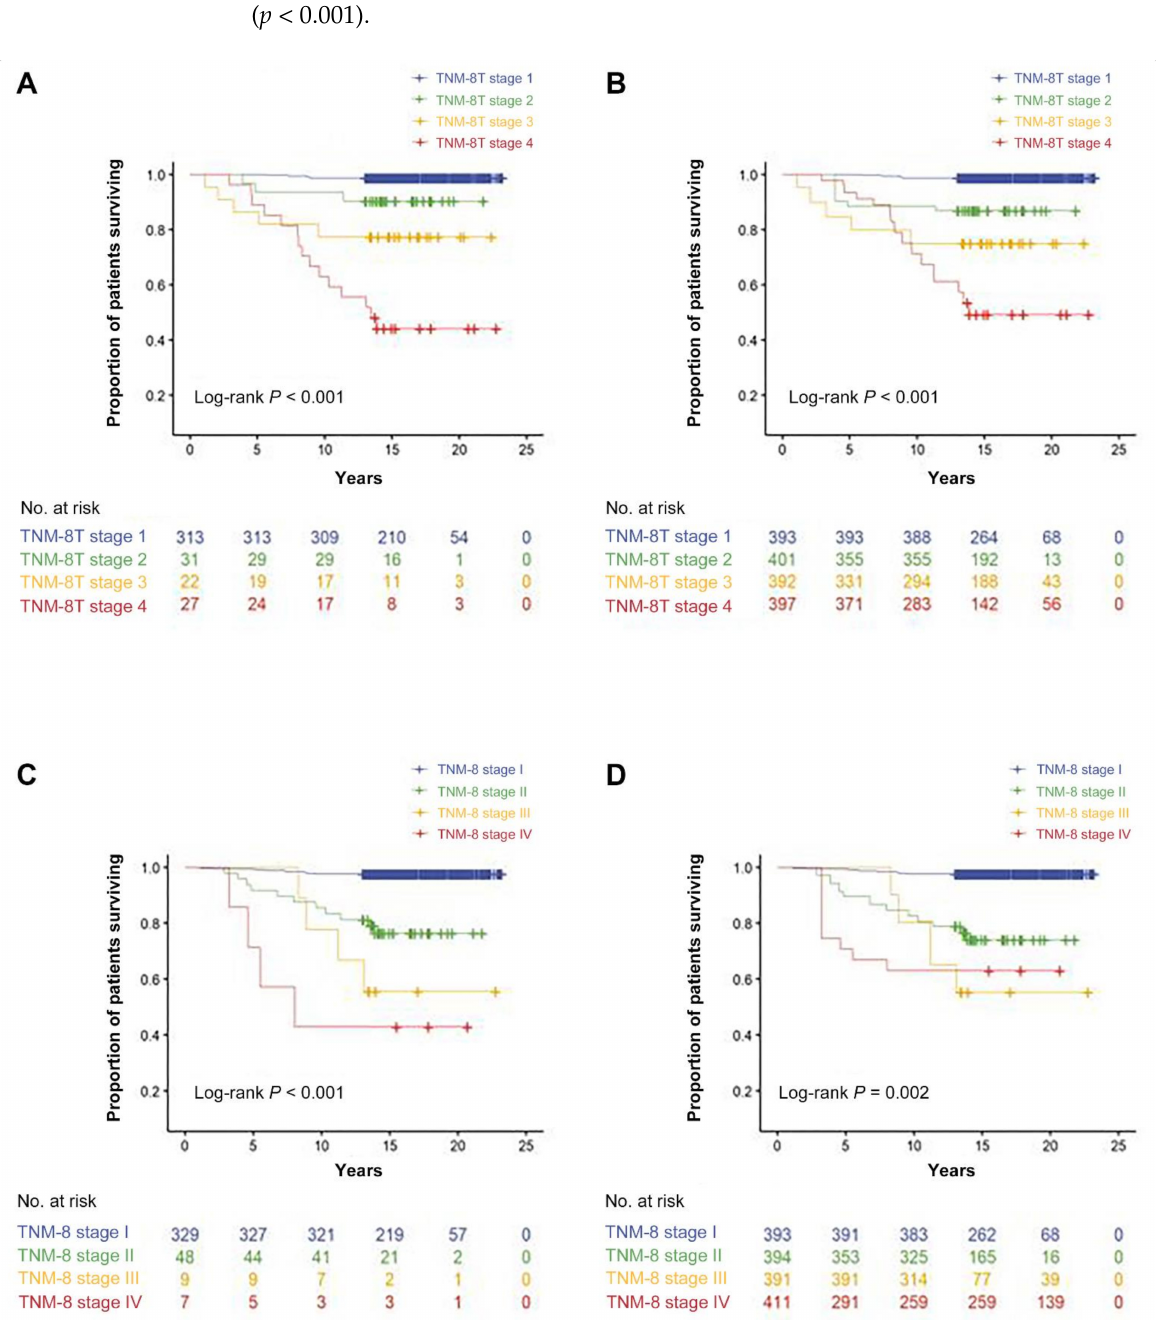
Figure 1. Thyroid cancer-specific survival according to TNM-8T with Kaplan–Meier survival curves ( A ) and adjusted survival curves ( B ). Thyroid cancer-specific survival according to TNM-8 with Kaplan–Meier survival curves ( C ) and adjusted survival curves ( D